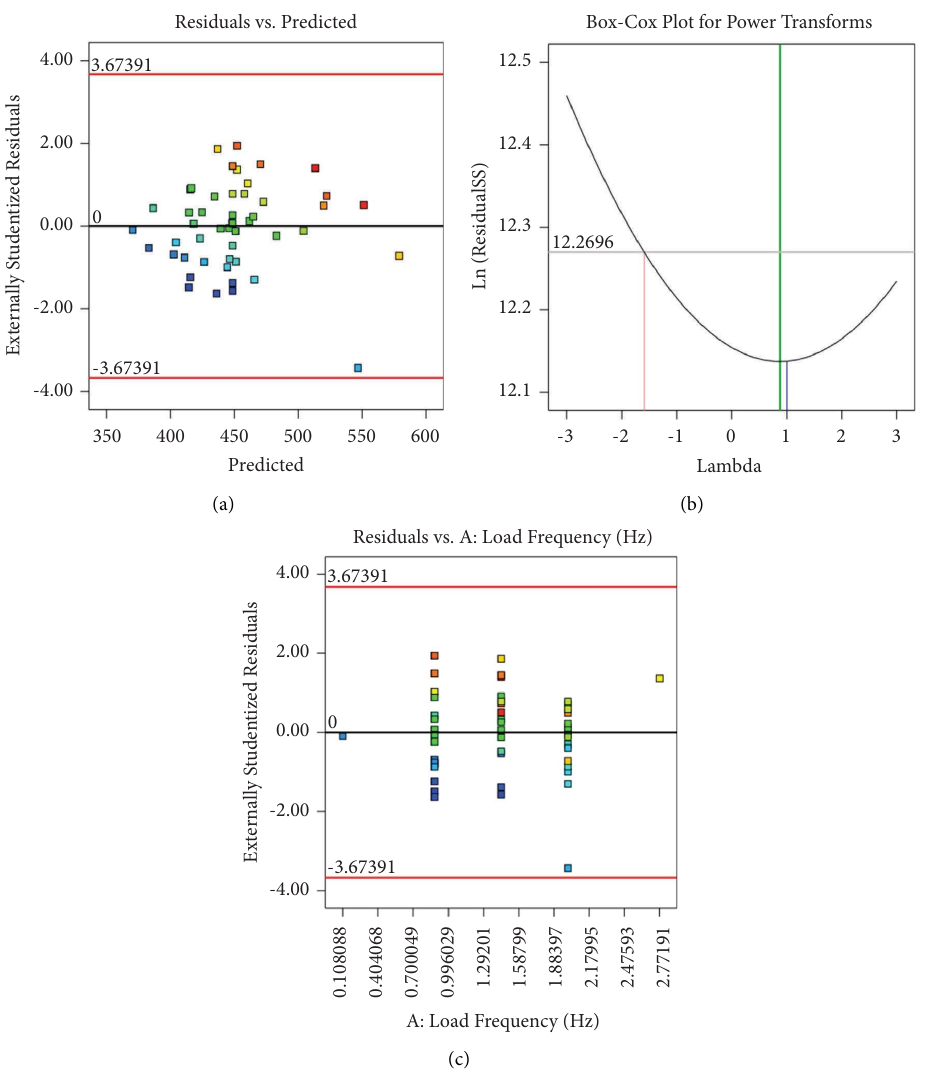
Figure 8: (a) Residuals vs. predicted values for efective stifness. (b) Box–Cox plot for efective stifness. (c) Residuals vs. process parameter for efective